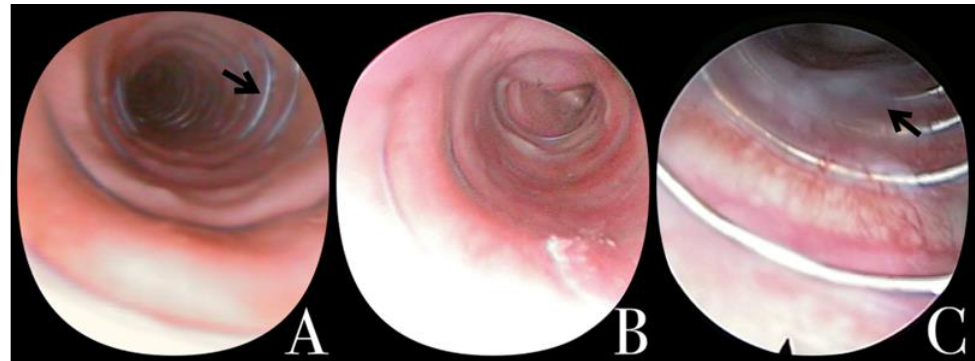
Figure 1. Tracheoscopy evaluation. ( A ) Naked MSS. No MSS contact (1) (arrow). ( B ) >80% MSS coated (2) (collapse of the canine can be observed caudal to the MSS). ( C ) Moderate mucous retention; isolated liquid mucous (1). MSS: Metallic spiral stent.